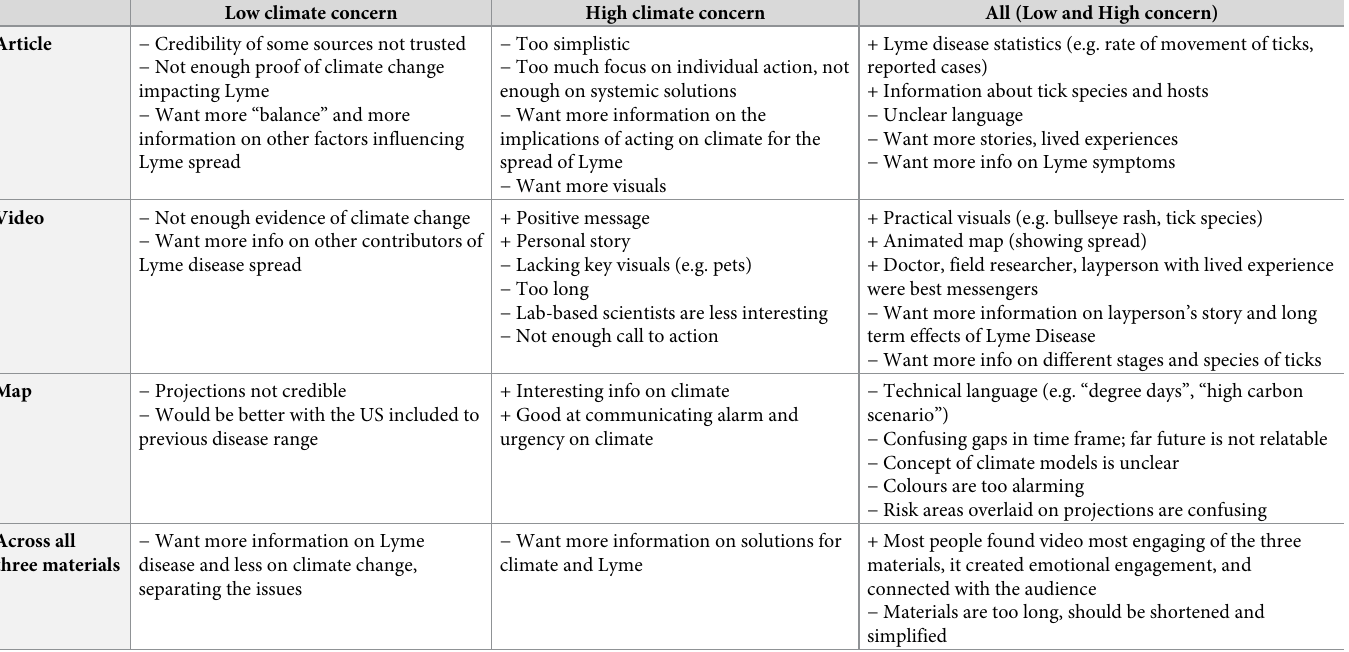
Table 2. Summary of common strengths (+) and criticisms and recommendations (-) of each material and comparison across materials for low concern (W2, B2, M2), high concern (W1, B1, M1), and all